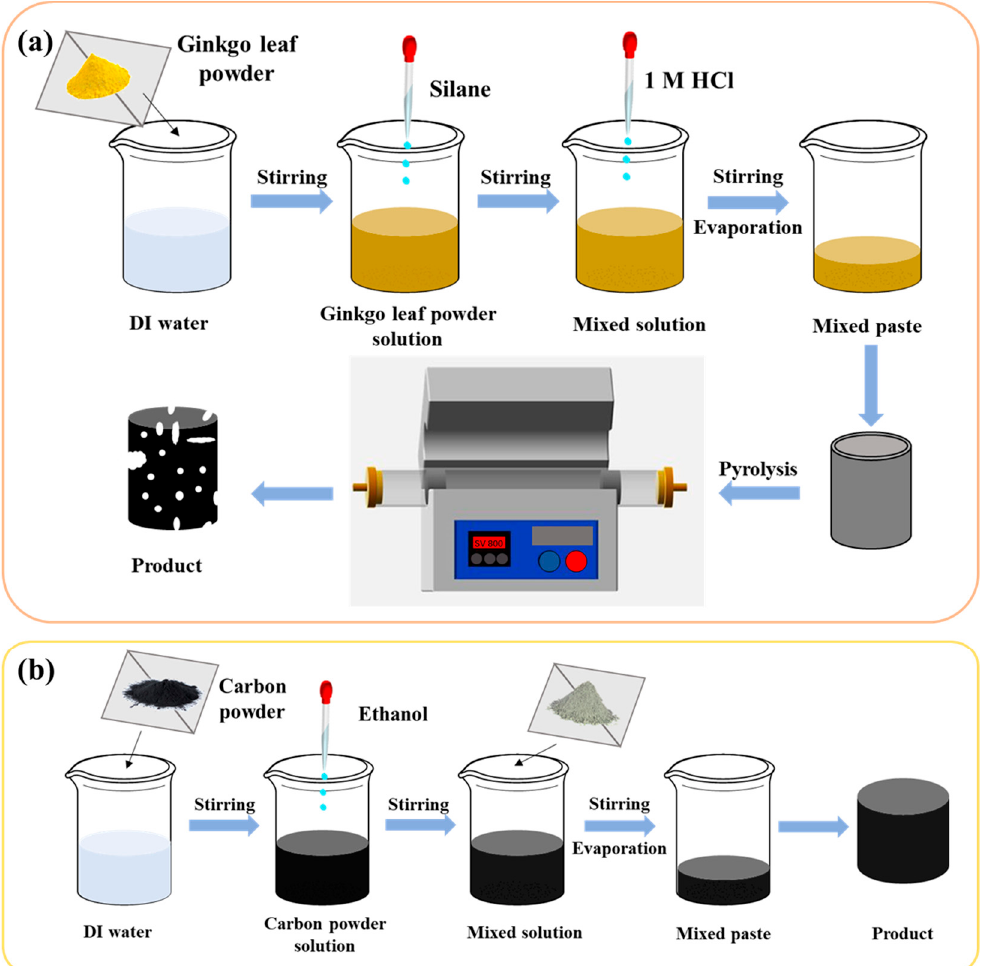
Figure 2. ( a ) Synthesis of ginkgo leaf biochar modified by TEOS; ( b ) inorganic-skeleton-reinforced bio-carbon with cement and fl y ash.